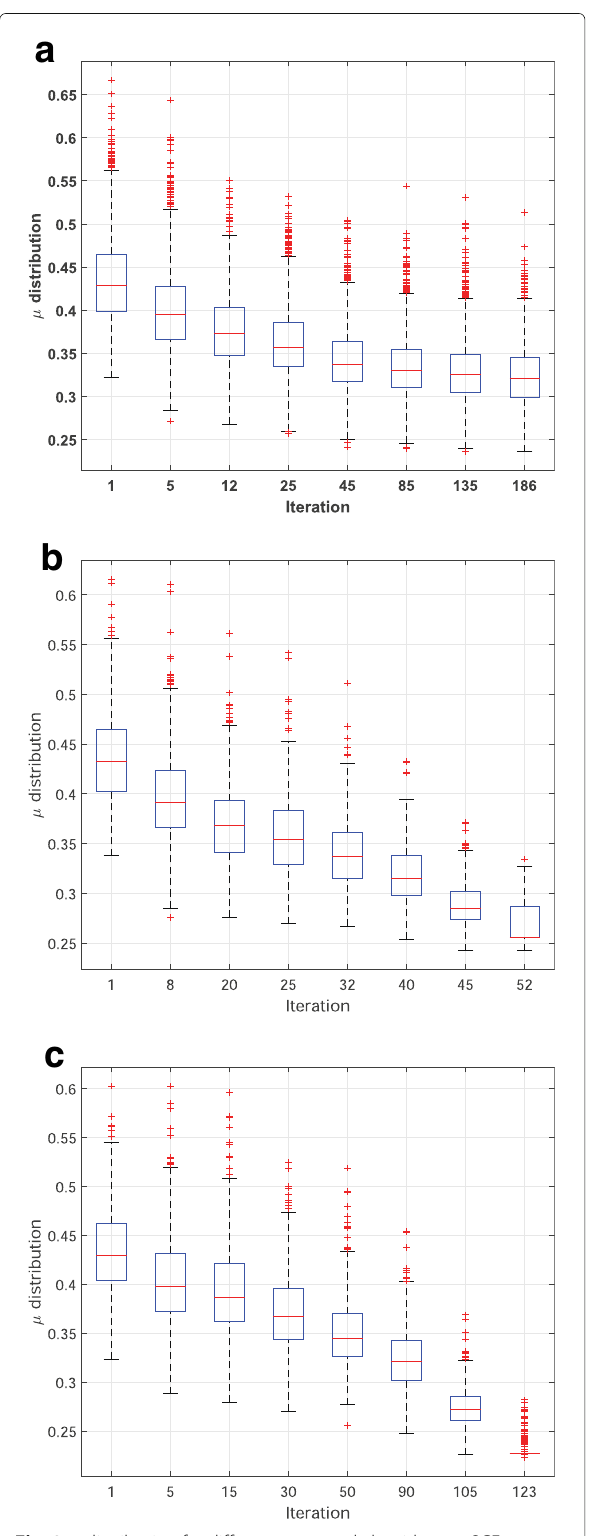
Fig. 3 μ distribution for different proposed algorithms. a SCE algorithm, b EEDA algorithm, and c PCE algorithm